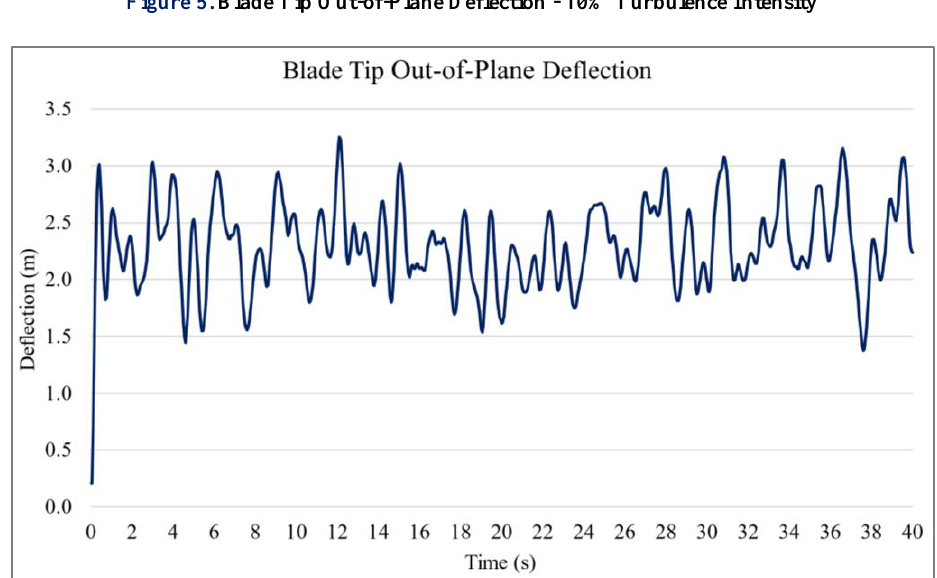
Figure 6. Blade Tip Out-of-Plane Deflection - 25% Turbulence Intensity